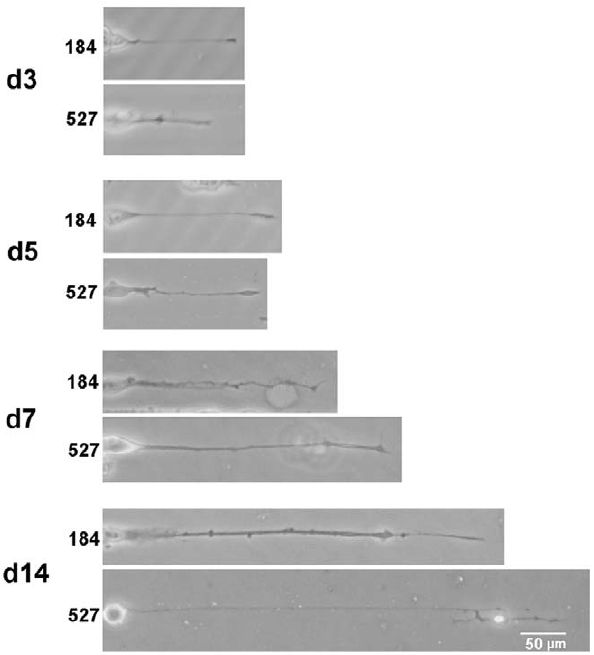
Figure 6. Representative phase contrast images show single neurites extending from the cell body of PC12 cells. The PC12 cells were differentiated into neuron-like cells and cultured on 5 kPa and 1.72 MPa PDMS (Sylgard 527 and Sylgard 184, respectively). Laminin was micropatterned as 20 m m wide, 20 m m spaced lines to direct the linear extension of neurites, which were imaged at 3, 5 7 and 14 days. The neuron length increased with culture time and was qualitatively similar between the two PDMS types. Scale bar is 50 m m.